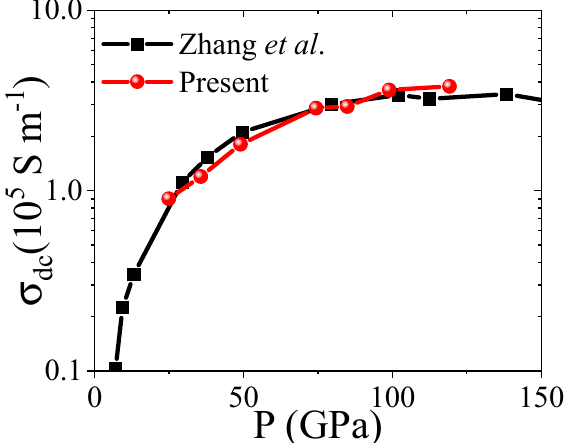
Figure 6. The direct current conductivities σ dc using PBE functional along the Hugoniot curve, compared with the result of Zhang et al. [24].